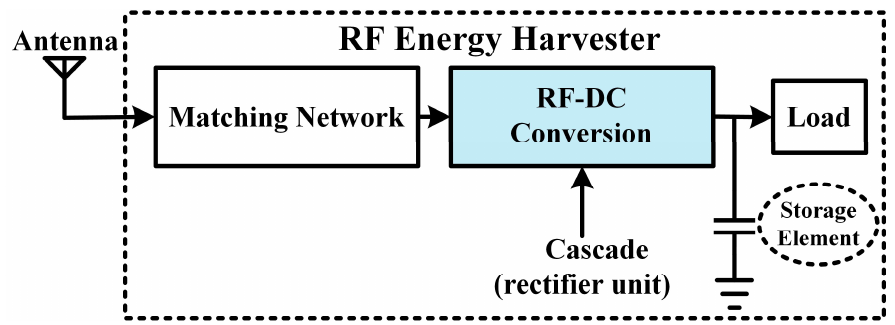
Figure 1. Block diagram of Radio Frequency (RF) energy harvester.